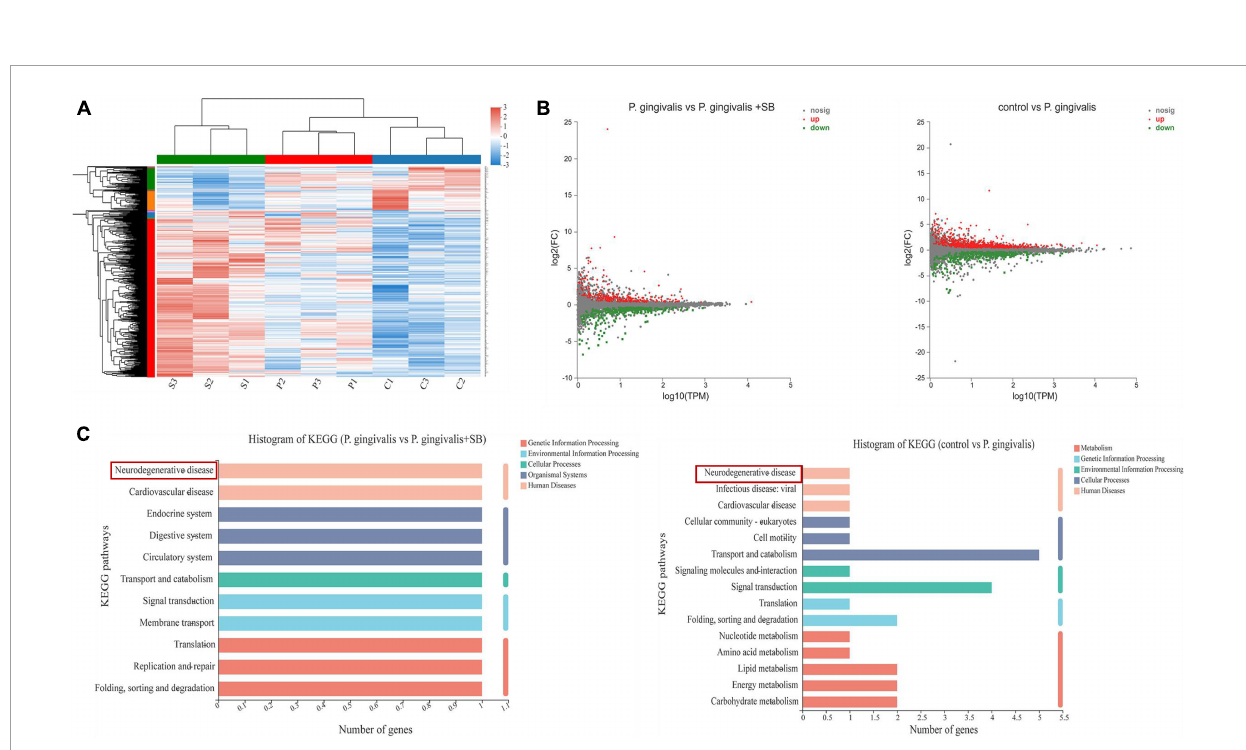
FIGURE4 The transcriptome sequencing results. (A) Heatmaps of significantly changed genes after treatment (|log| ≥ 2, p < 0.05) ( n = 3 per group. “s” refers to the P. gingivalis + SB group, “p” refers to the P. gingivalis group, and “c” refers to the control group). (B) MA plot of the difference in expression between P. gingivalis and the control group and vs. P. gingivalis + SB. (C) The 20 most significantly enriched KEGG metabolic